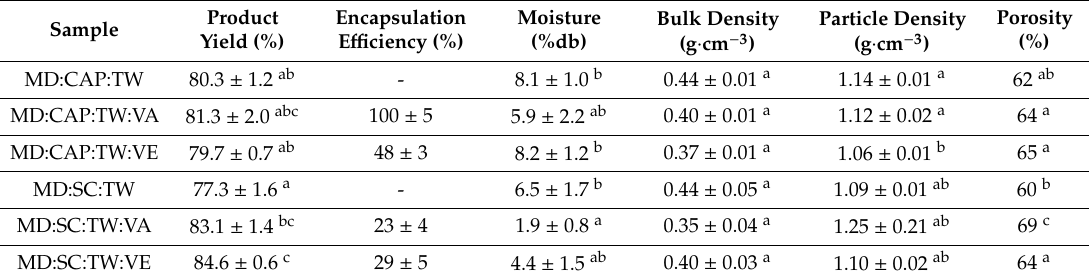
Table 2. Product yield, encapsulation e ffi ciency, moisture content, bulk density, and particle (true) density and porosity of microcapsules. MD: Maltodextrin, CAP: Capsul ® , SC: Sodium caseinate